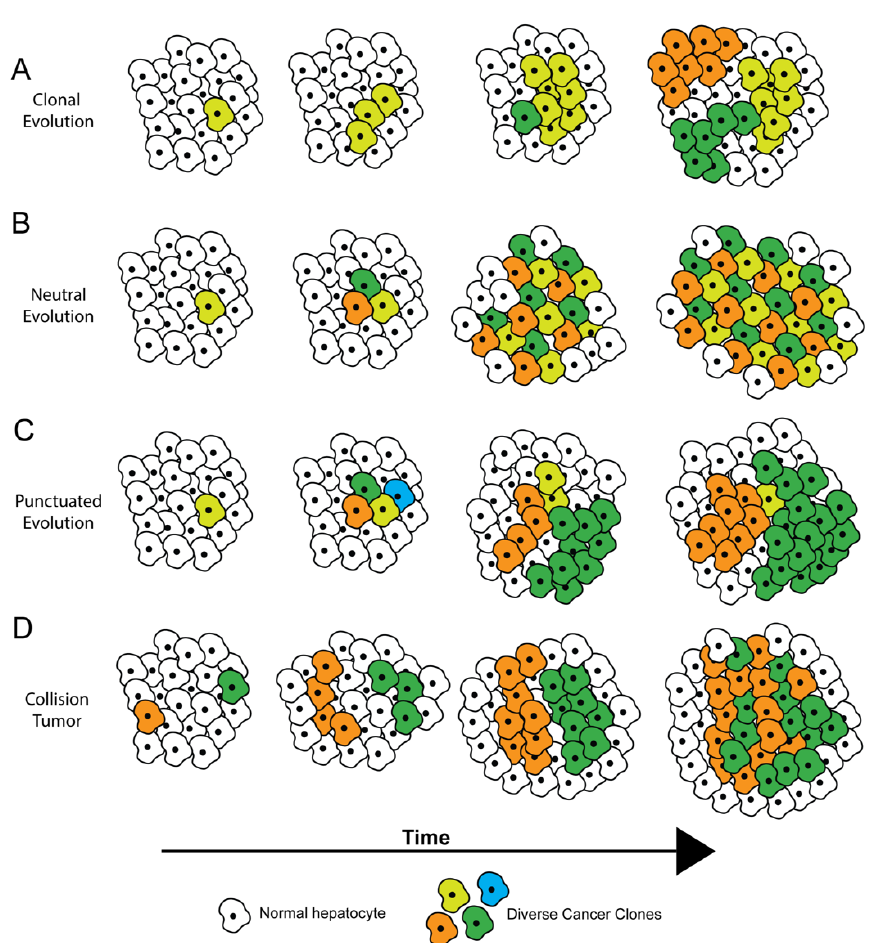
Figure 1. Theories of tumor evolution. ( A ) Clonal evolution, where all tumor cells diverge from a common ancestor with a fitness advantage, and subclones emerge with acquired genomic alterations. ( B ) Neutral evolution, where mutations randomly accumulate over time with no one population having a selective advantage. ( C ) Punctuated evolution, where a large number of genetic alterations occur at a point in time, but only a few dominant clones persist. ( D ) Collision tumor, where physically distant clonal cell populations converge as they proliferate, eventually colliding and forming a single tumor.